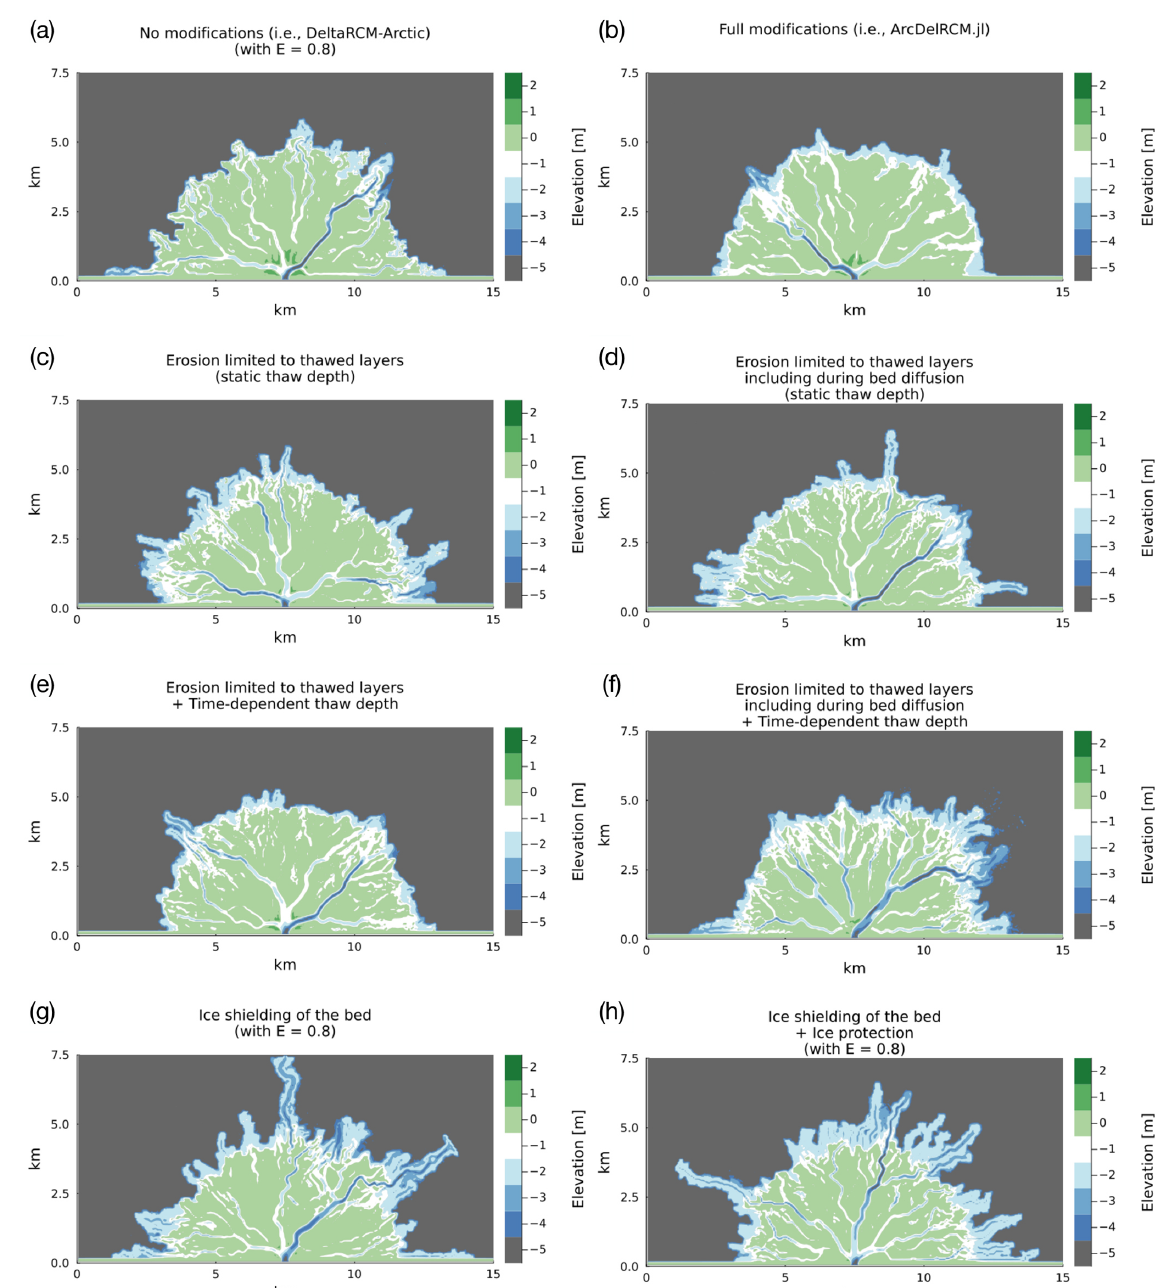
Figure 5. Bed-elevation output of DeltaRCM-Arctic (a) and ArcDelRCM.jl (b) and with modifications described in Sect. 2.2.1 to 2.2.4 applied individually or in tandem, as indicated by the title of each panel (c–h) . Note the 2m ramp in the full model and the case in which ice shielding and ice protections are applied